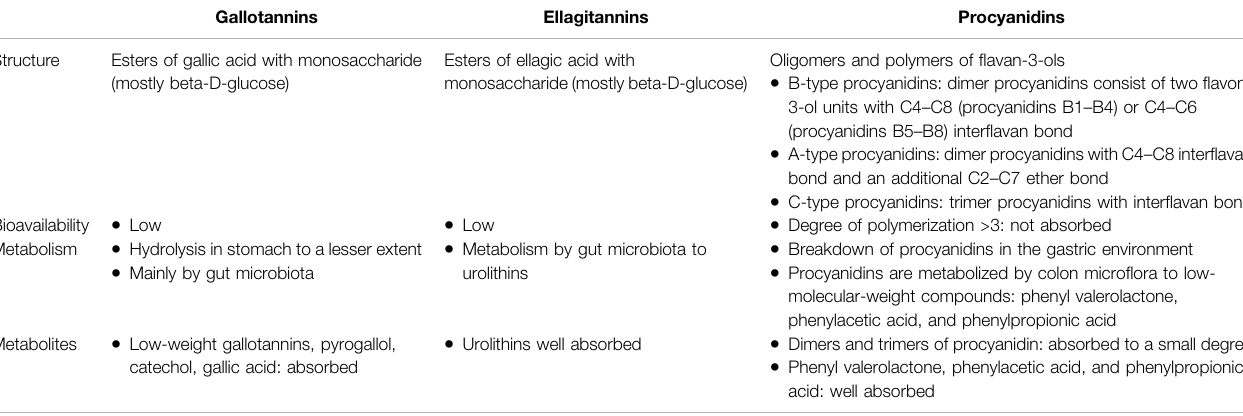
TABLE 1 | Structural characterization of tannins and their metabolism.